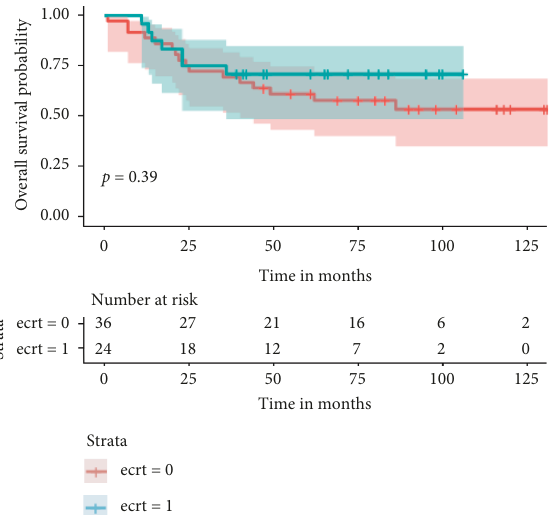
Figure 3: Kaplan-Meier curves showing overall survival stratified by use of reimplantation. Green line with reimplantation of tumor bone and the red without. Time is in